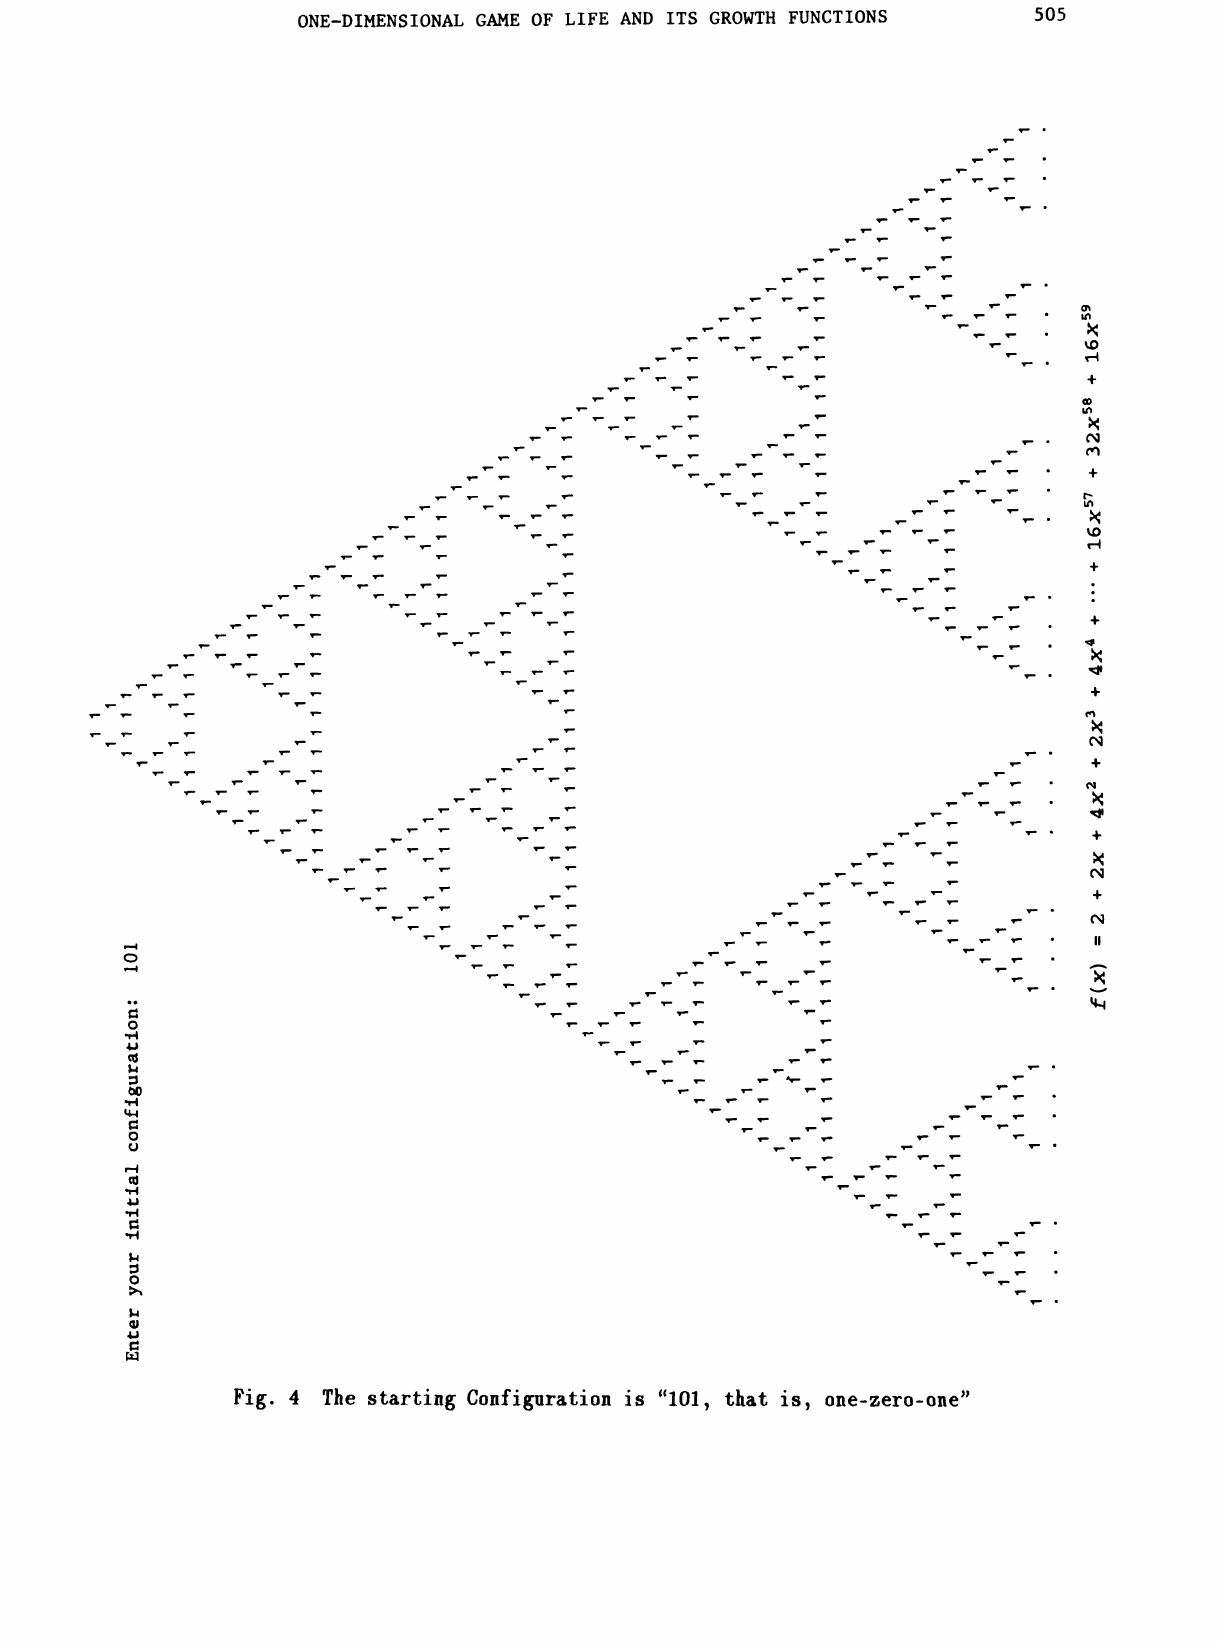
Fig. 4 The starting Configuration is "101, that is,